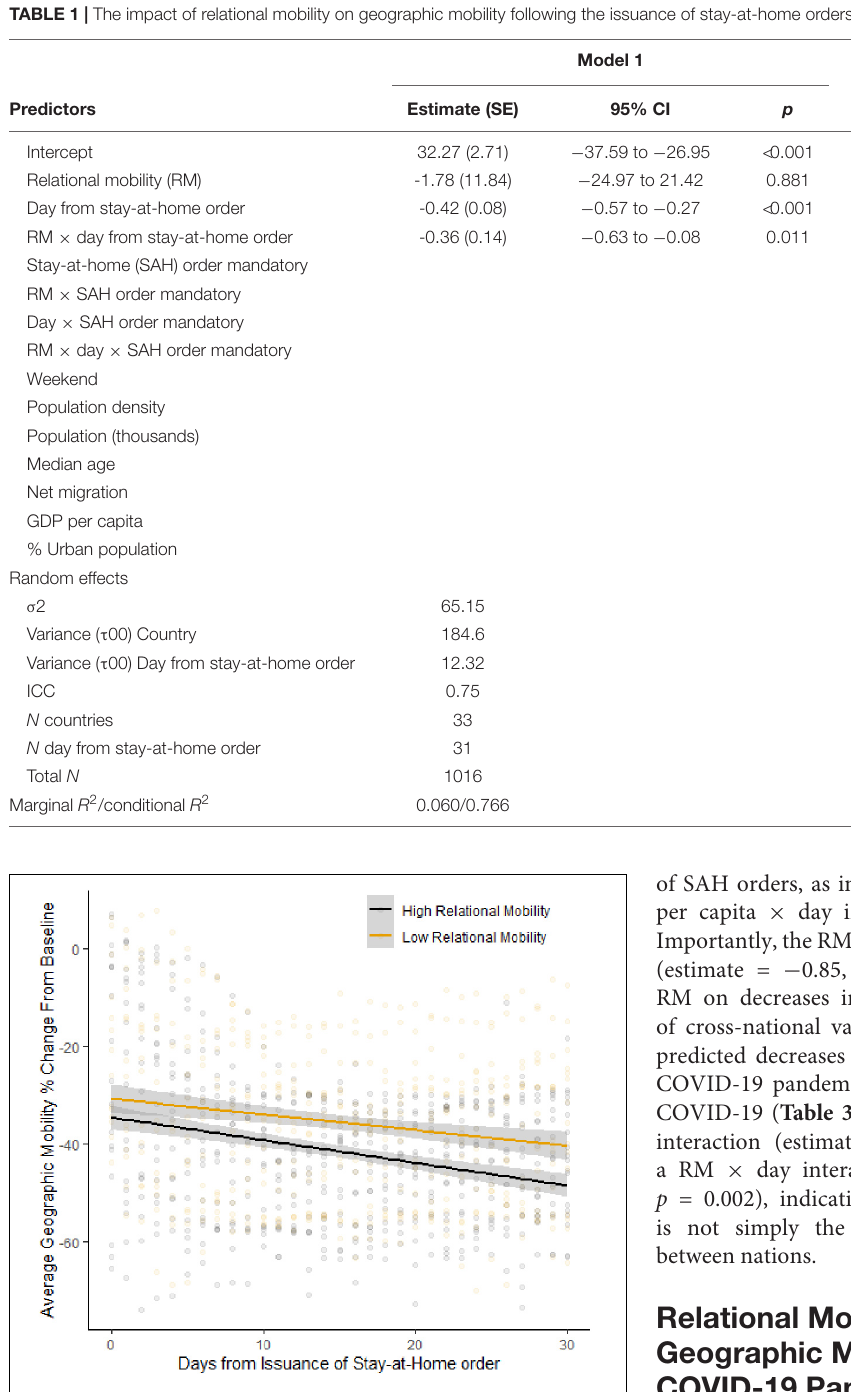
FIGURE 1 | Changes in geographic mobility in the month following the issuance of stay-at-home orders in countries with high versus low levels of relational